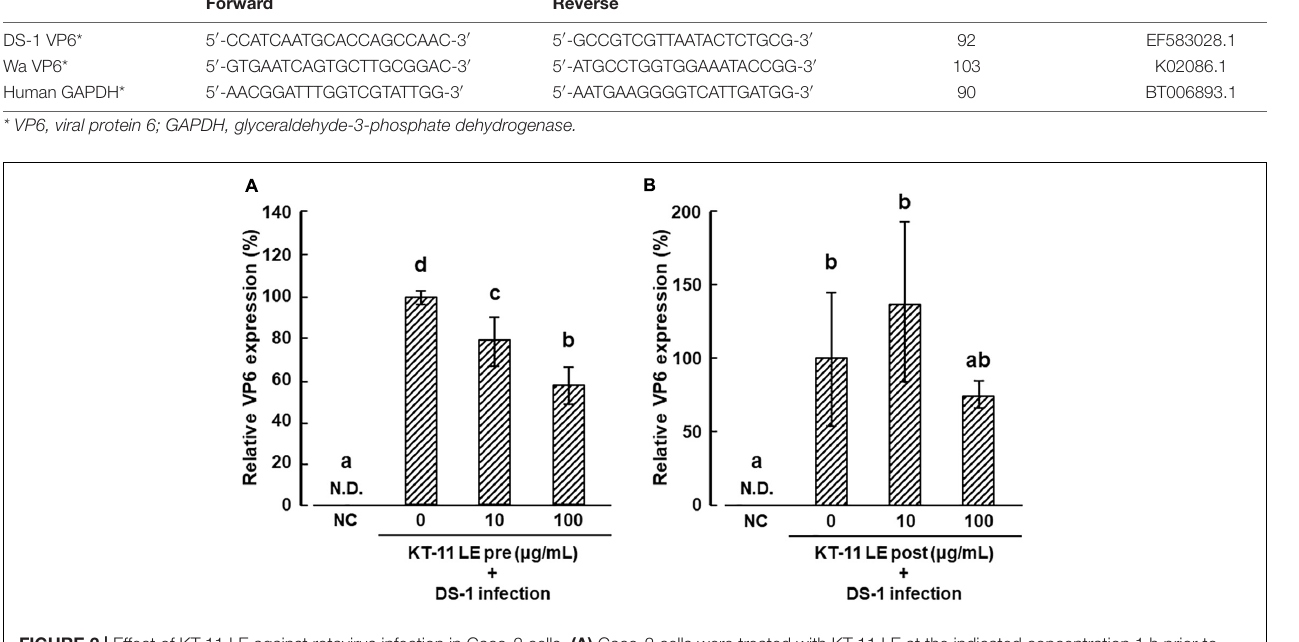
FIGURE 2 | Effect of KT-11 LE against rotavirus infection in Caco-2 cells. (A) Caco-2 cells were treated with KT-11 LE at the indicated concentration 1 h prior to DS-1 infection. The expression of VP6 in Caco-2 cells 24 h after the infection was evaluated. The results are shown as means with standard deviations relative to KT-11 LE-untreated control ( n = 3). N.D. denotes not detected. Different letters denote a significant difference at p < 0.05. (B) Caco-2 cells were treated with KT-11 LE at the indicated concentration after DS-1 infection. The expression of VP6 in Caco-2 cells 24 h after the infection was evaluated. The results are shown as means with standard deviations relative to KT-11 LE-untreated and viral-infected control ( n = 3). NC represents the condition of viral-uninfected (and also KT-11 LE-untreated) condition. N.D. denotes not